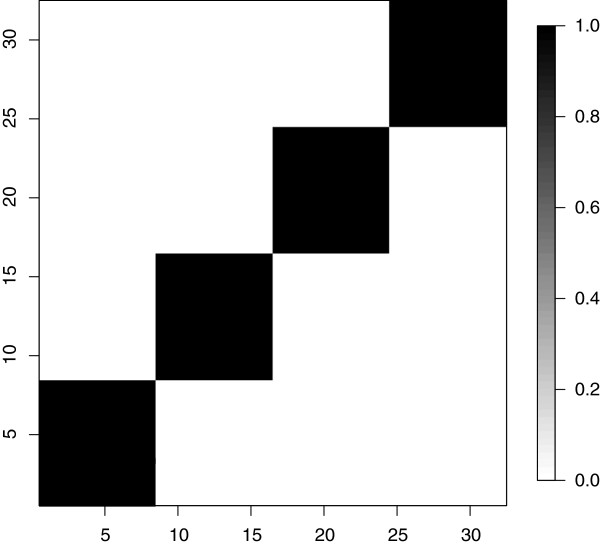
Marginal posterior probabilities of each pair of columns belonging to the same cluster.